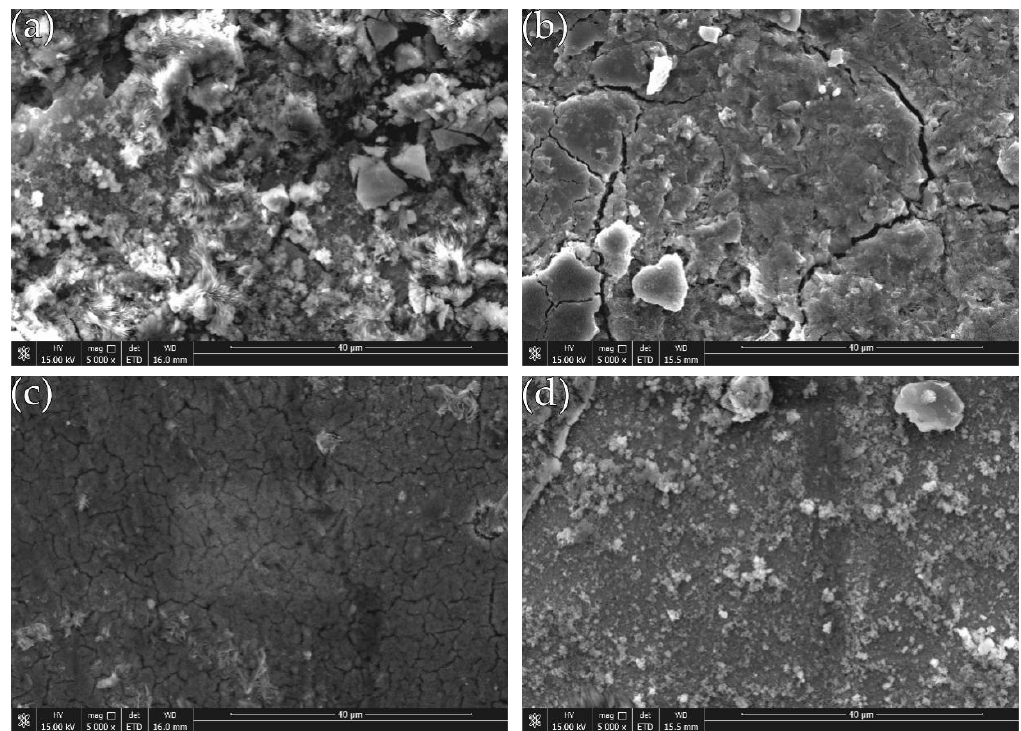
Figure 11. Surface morphology after plating corrosion: ( a ) Ni-Fe-Co-P; ( b ) Ni-Fe-Co-P-0.5 g / L CeO 2 ; ( c ) Ni-Fe-Co-P-1 g / L CeO 2 ; and ( d ) Ni-Fe-Co-P-1.5 g / L CeO 2 .